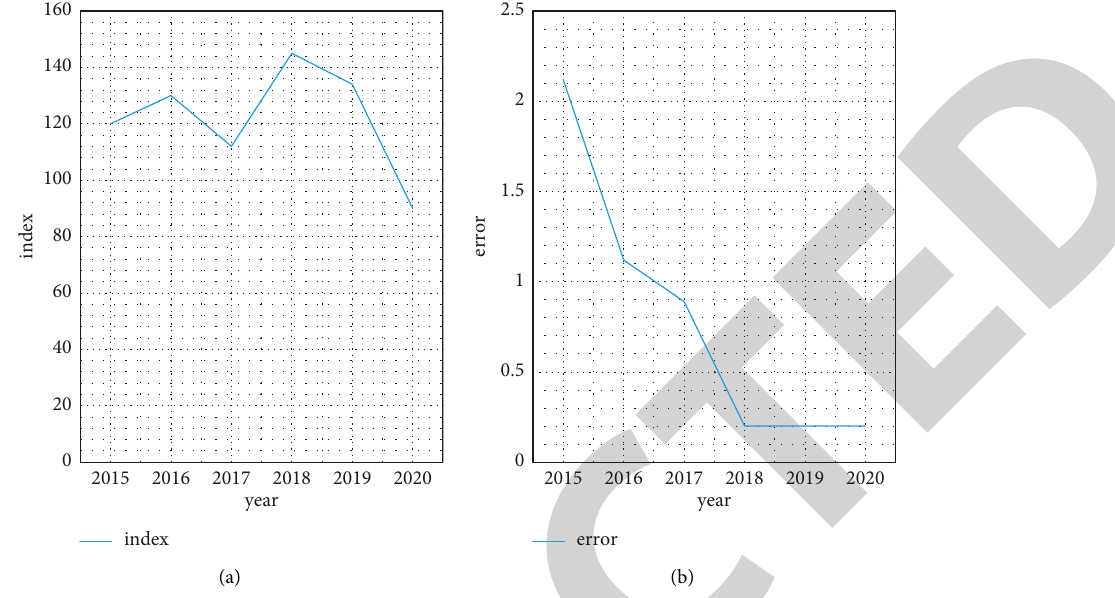
Figure 8: Early warning prosperity index. (a) Prosperity index. (b) Particle swarm optimization